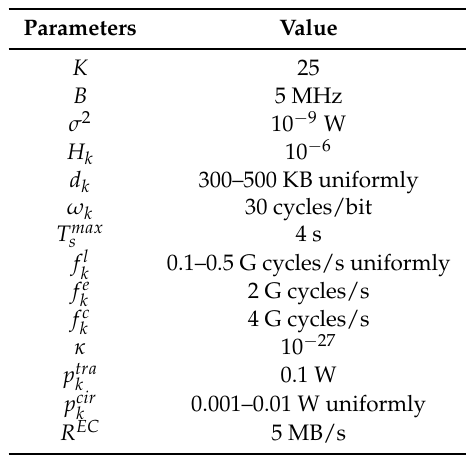
Table 2. Default parameters